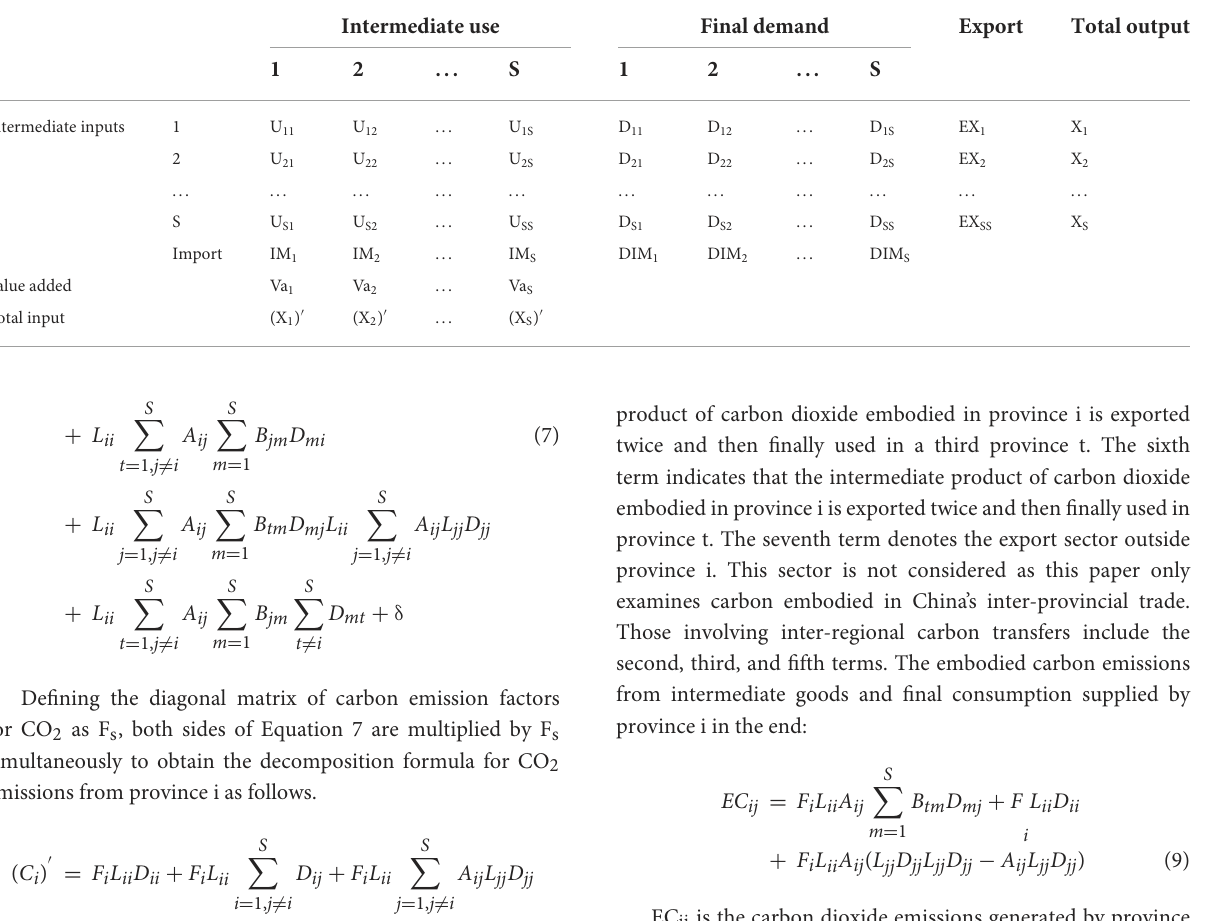
TABLE 1 Multi-regional input-output tables for China.